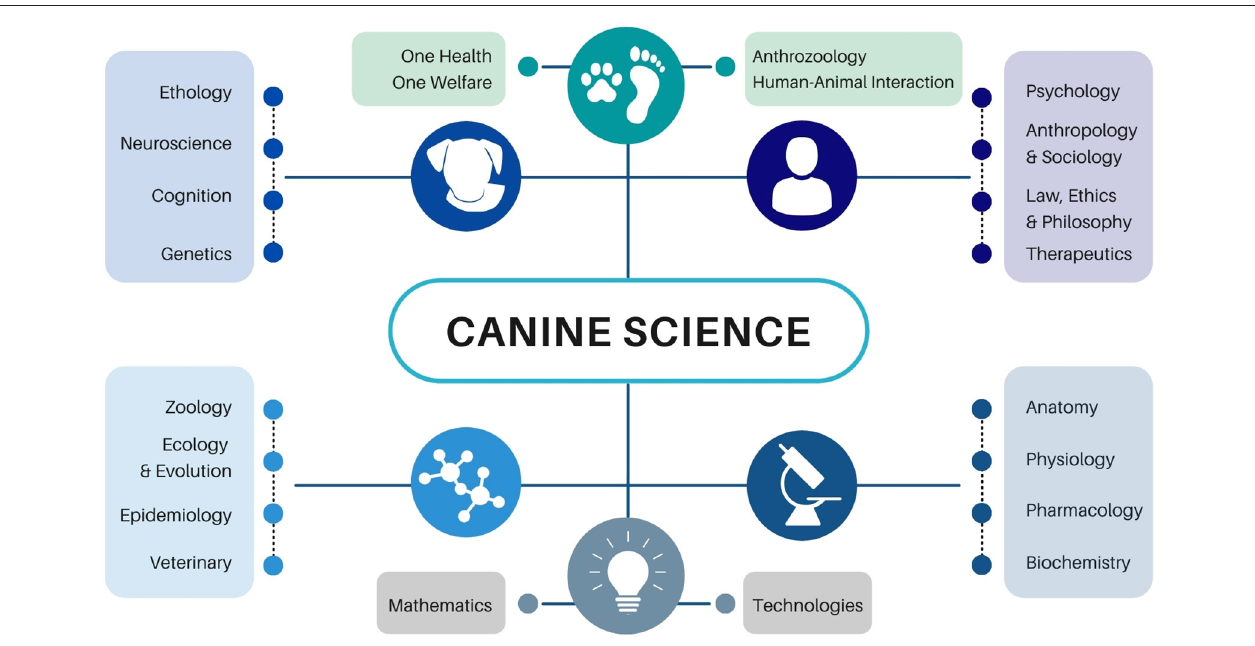
FIGURE 1 | Canine science is an interdisciplinary field with connections to other traditional and emerging areas of research. The specific fields shown overlap in ways not depicted here and are not an exhaustive list of disciplines contributing to canine science. Rather, they are included as examples of the diversity of scholarship in canine